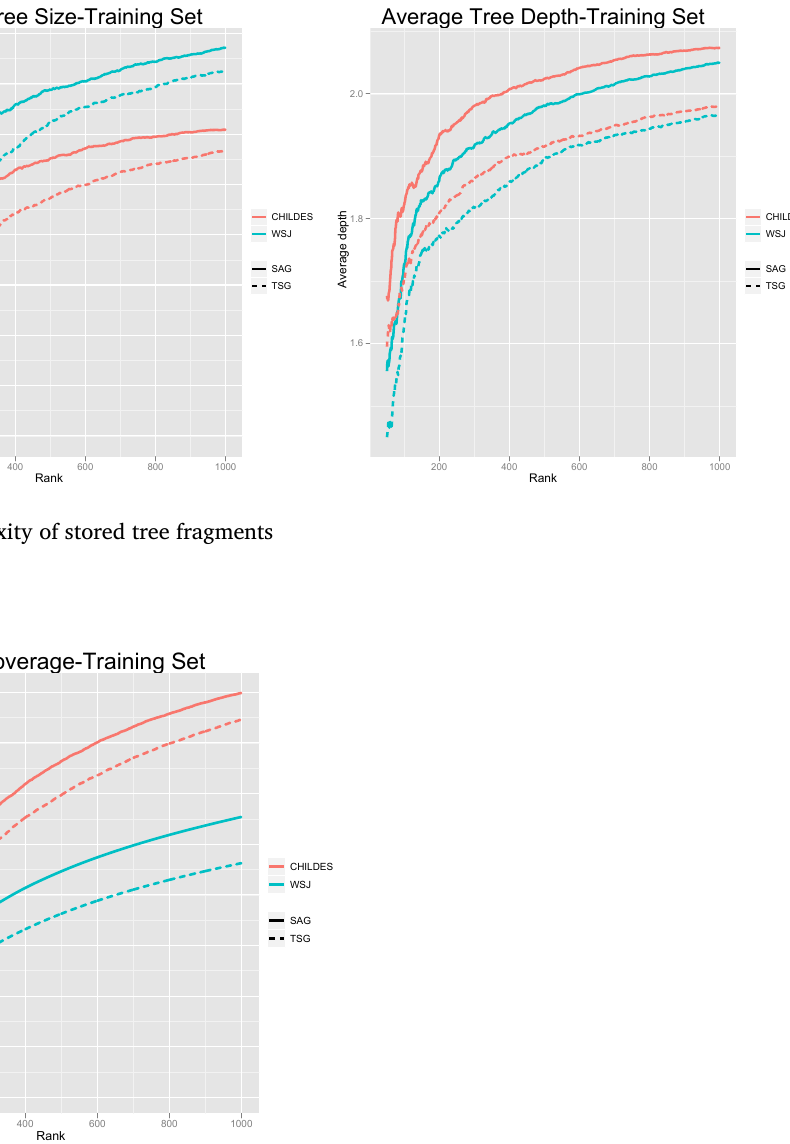
Figure 7: Cumulative